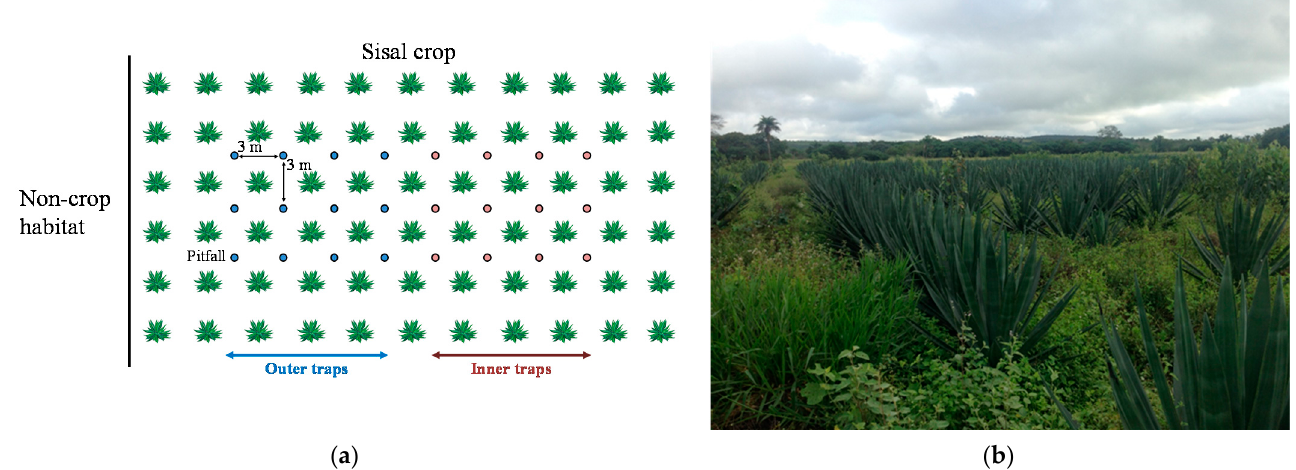
Figure 1. ( a ) Diagram of the experimental design; ( b ) planting area of sisal culture in Antônio Gonçalves, Bahia, Brazil.